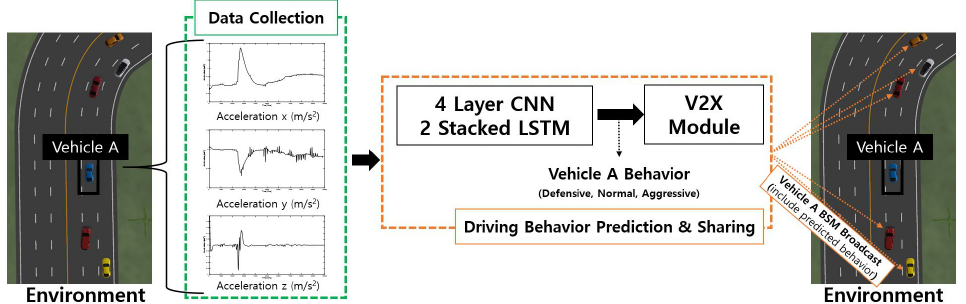
Figure 1. The proposed 4-layer CNN-2 stacked LSTM-V2X system for driving behavior classification and